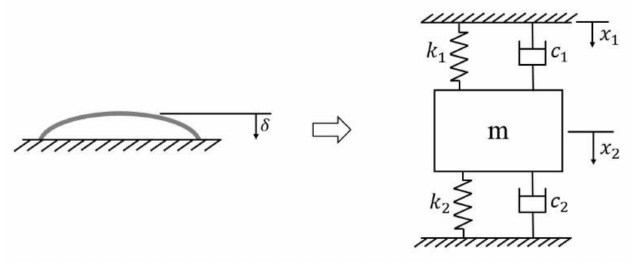
Figure A1. Lump mass model for a THUNDER